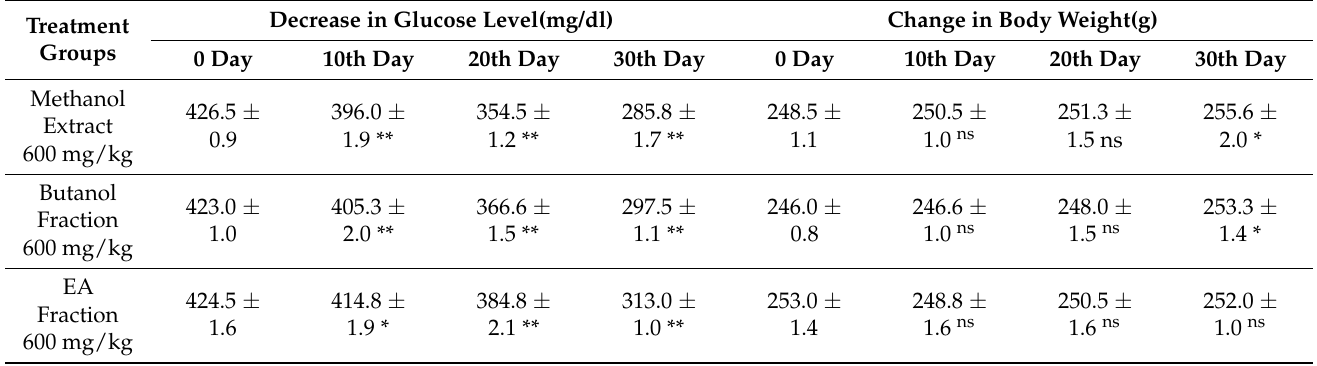
Table 7. Effect of B. calliobotrys on mean blood glucose level and body weight in diabetic rats on 30th day